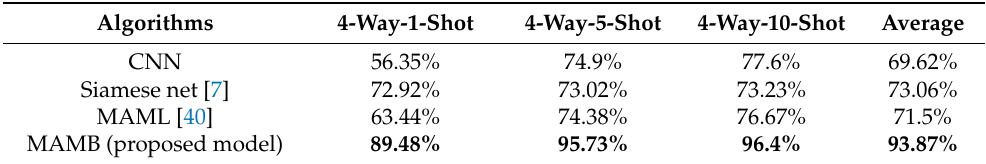
Table 4. Comparison of MAMB with different algorithms in the few-shot diagnosis of the generator bearings for wind turbines.